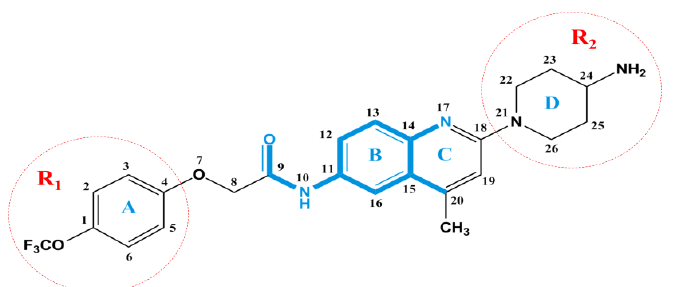
Figure 4. The optimal Compound 169 with common substructure of all molecules shown in bold. Two substituents R and R are denoted as red 1 2